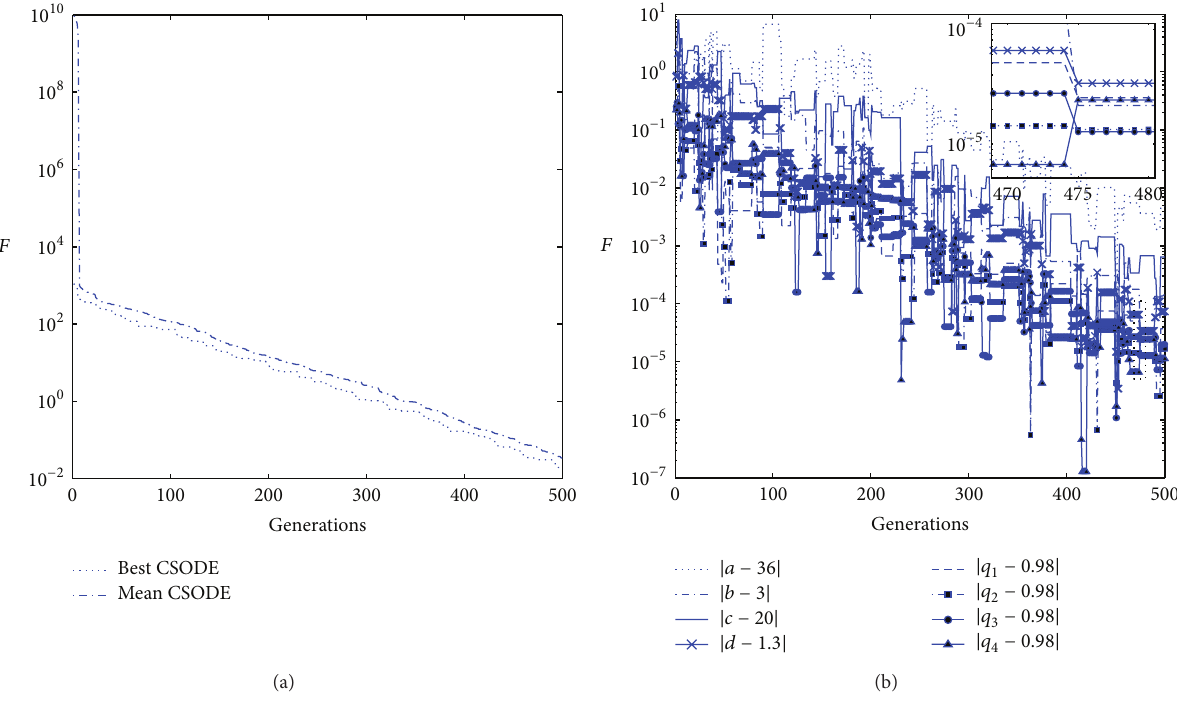
Figure 8: Evolution process for hyper fractional-order L¨u system.